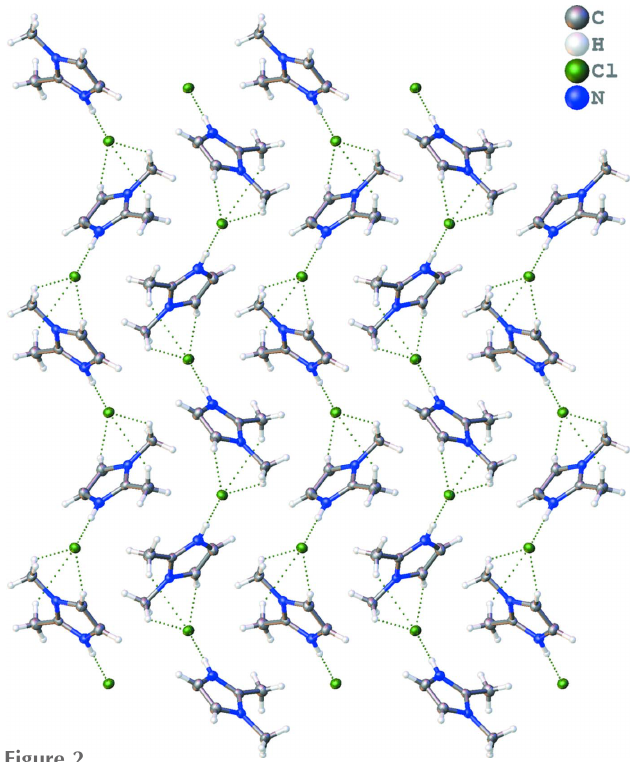
Figure 2 Packing diagram of the title compound showing a zigzag network of ion pairs held together through hydrogen bonds.